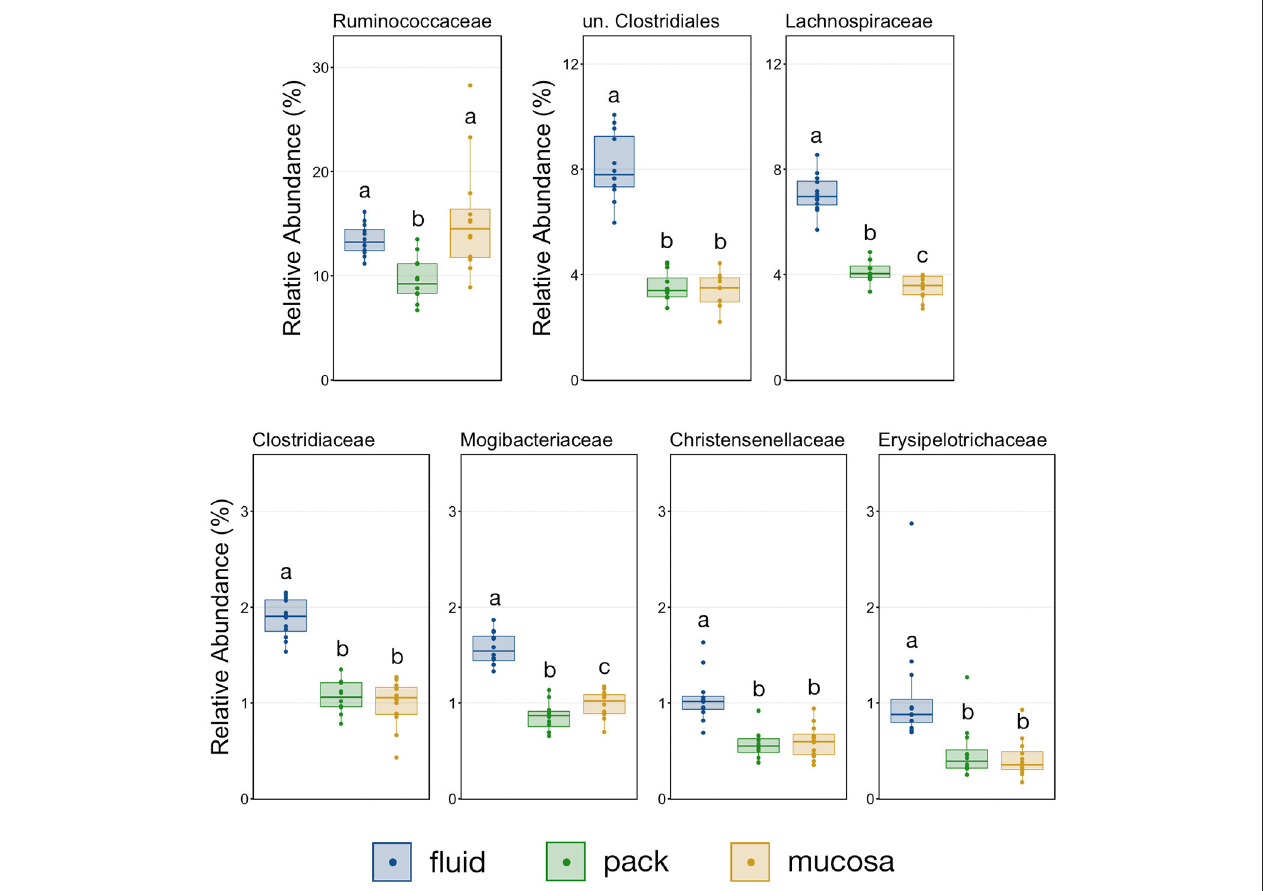
FIGURE 7 | Boxplot demonstrating the relative abundances of the seven families from the phylum Firmicutes discriminant of a ruminal micro-environments. Points represent individual animals, and the horizontal line in each boxplot represents the median relative abundance. Significant differences between the relative abundances of each family are illustrated by different letters (Pairwise Wilcoxon rank-sum with Benjamini-Hochberg correction, p < 0.05, n = 12).